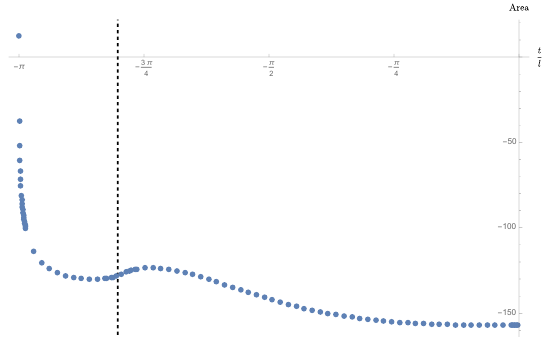
Figure 2 . The renormalized area as a function of time t . Both in the far past and in the far future, the renormalized area is a decreasing function of time. In a small neighborhood of the moment t (cid:3) when the topology of the CHI surface changes, the renormalized area increases with time. In the (cid:12)gure we have chosen r EH =‘ = 1 = 5, for which t (cid:3) (cid:25) (cid:0) 2 : 5 and is indicated by the dashed vertical